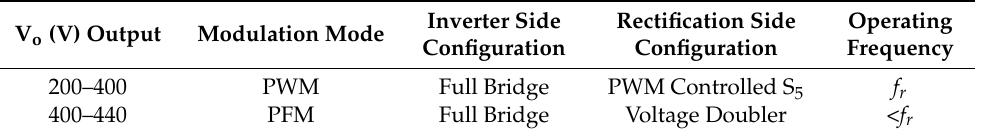
Table 1. Forward mode Control and Configuration Characteristics.